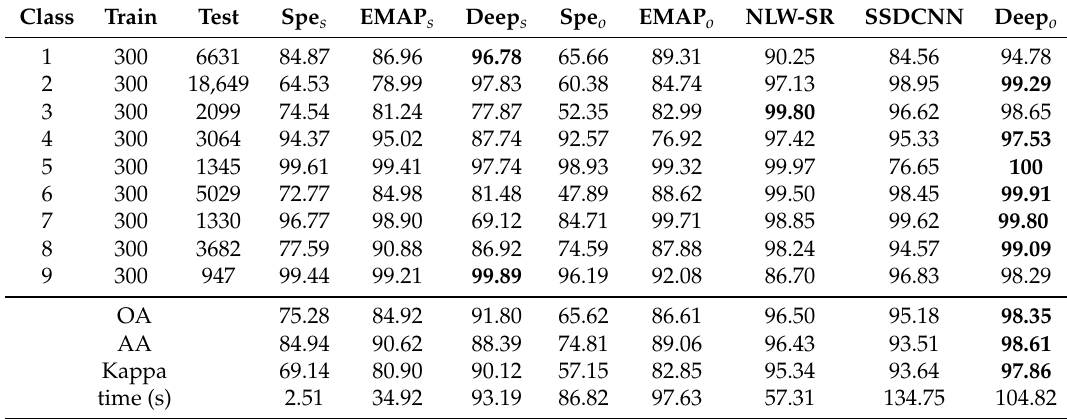
Table 2. OA, AA and Kappa statistic obtained after executing 10 Monte Carlo runs for the ROSIS Pavia University